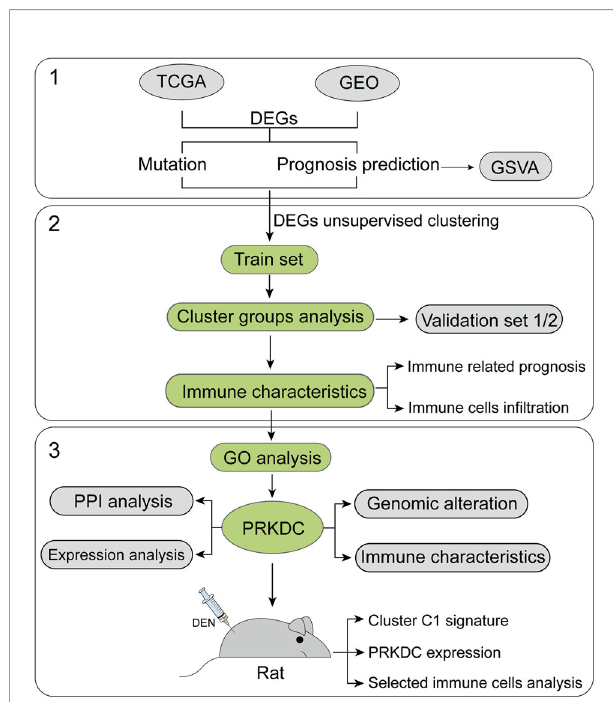
FIGURE 1 | Flowchart of the study. Nineteen public HCC datasets containing 1,408 tumor and non-tumor cases were included and categorized into three independent cohorts according to the data platform. We developed the eHCC-related gene-set signature in the training set and two validation sets. Further, we integrated gene-set signature with immune characteristics, prognosis, genic alteration, and biological functions to investigate the prognostic value. HCC, hepatocellular carcinoma; eHCC, early-stage hepatocellular